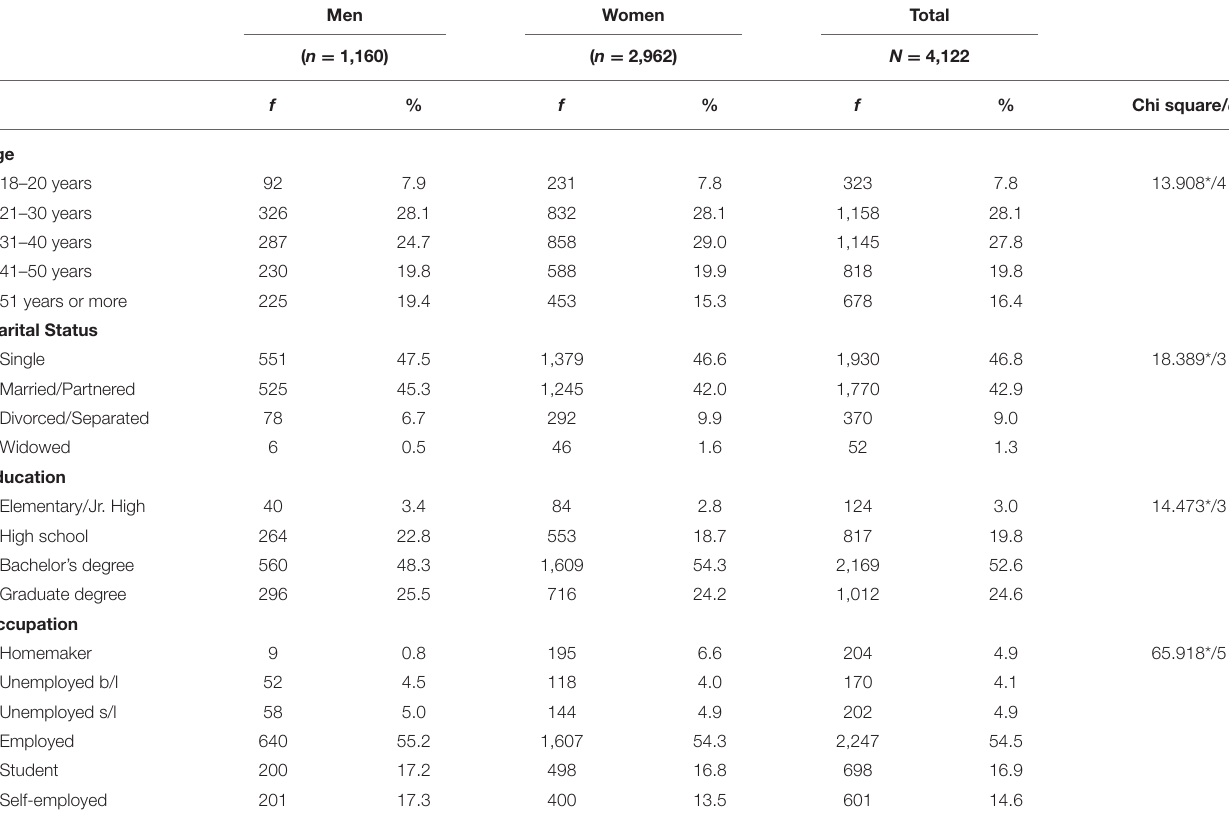
TABLE 1 | Sociodemographic